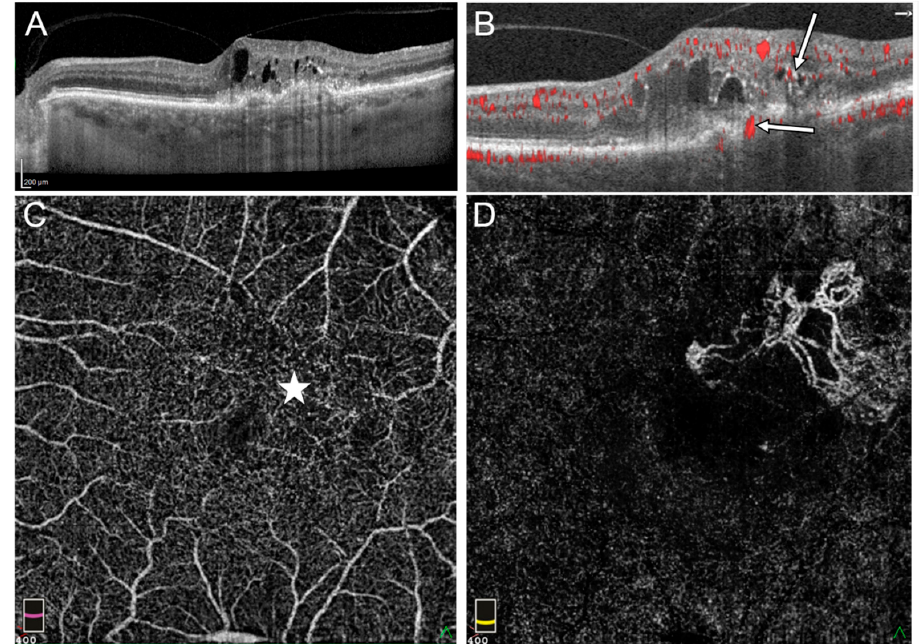
Figure 2. Stage III RAP in the left eye: ( A ) OnSDOCT cross-section, the intraretinal cysts and hyperreflective foci in outer retinal layers can be observed, ( B ) OCTA cross section reveals flows within sensory retina corresponding to IRN (thin arrow) and the flow passing RPE (thick arrow), ( C ) en face OCTA on the level of the deep vascular plexus (DVP) demonstrated irregular area of flow in superior temporal part of macula where intraretinal cysts are located (star), ( D ) in en face OCTA, flows of extrafoveal MNV on the level of external retina are visible.